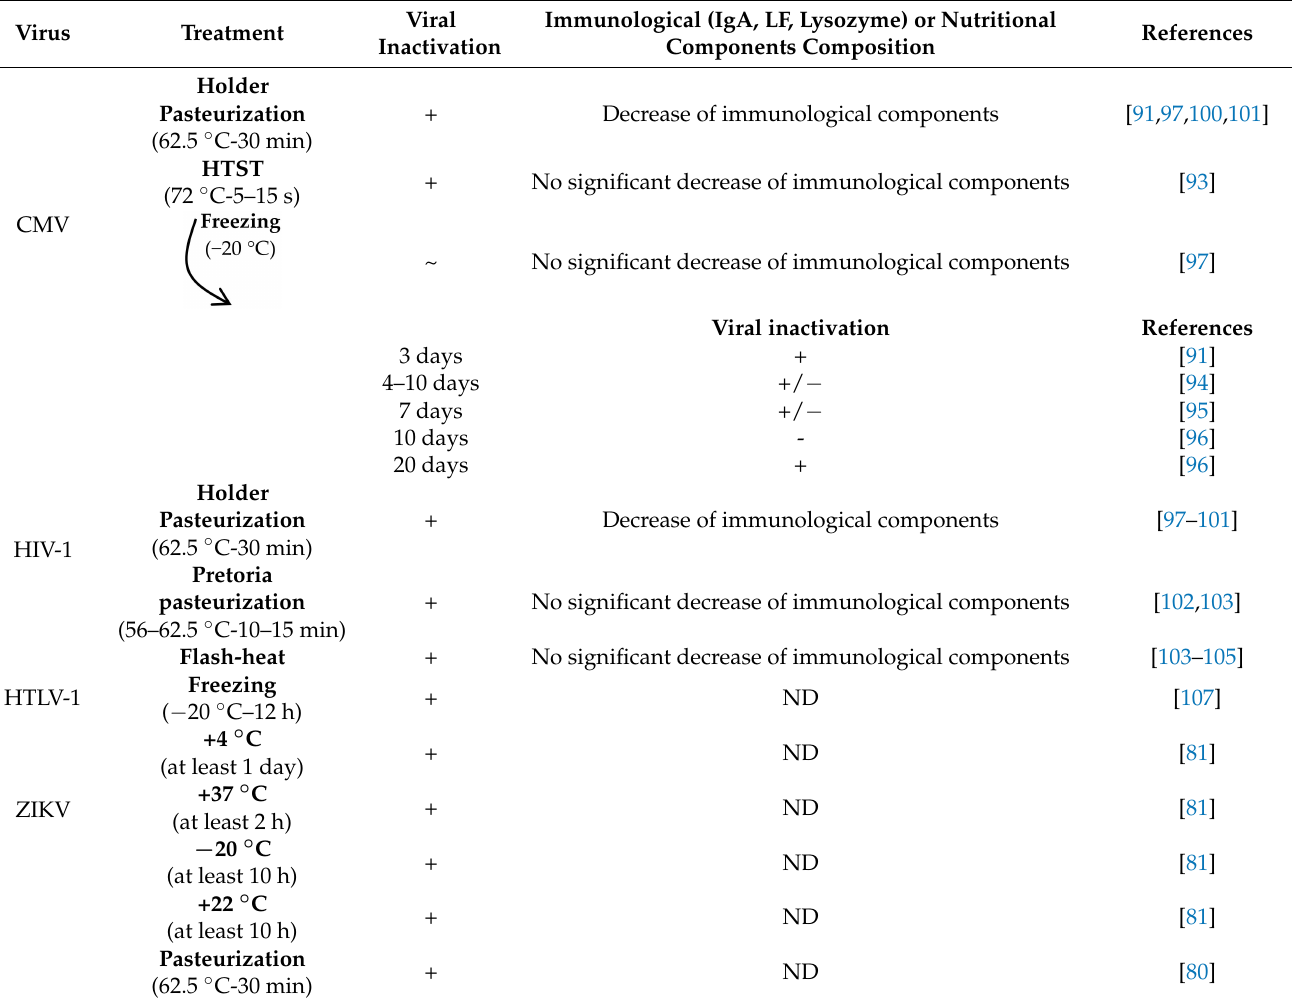
Table 2. Viral inactivation strategies in breast